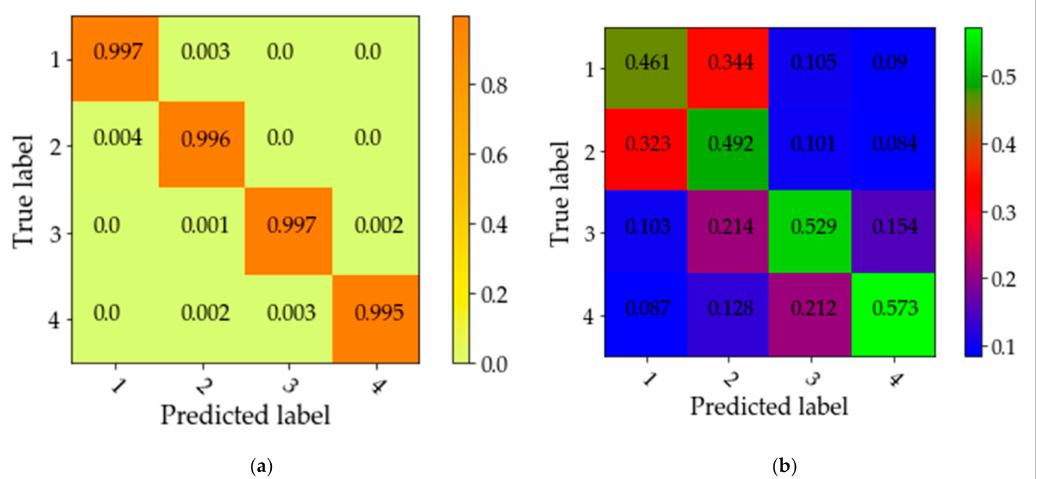
Figure 13. Normalized confusion matrix of classification effect; ( a ) low impedance fault (LIF) and ( b ) high impedance fault